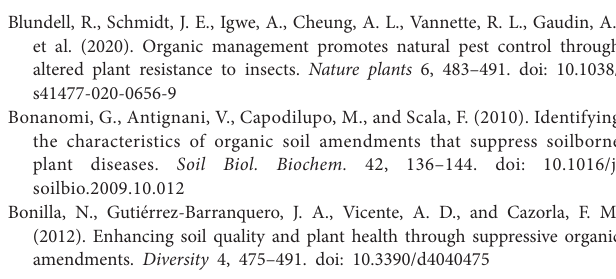
Supplementary Figure S1 | Spearman rank correlations between bacterial richness (Chao 1), bacterial diversity (Shannon), fungal richness (Chao 1), and fungal diversity (Shannon) and tomato disease incidence. Supplementary Figure S2 | Bacterial (A) and fungal (B) community composition at the phylum level. CFB, chemical fertilizer-amended bulk soil; CFR, chemical fertilizer-amended rhizosphere soil; OFB, organic fertilizer-amended bulk soil; and OFR, organic fertilizer-amended rhizosphere soil. Supplementary Figure S3 | Spearman rank correlations between sensitive bacterial genera and physicochemical